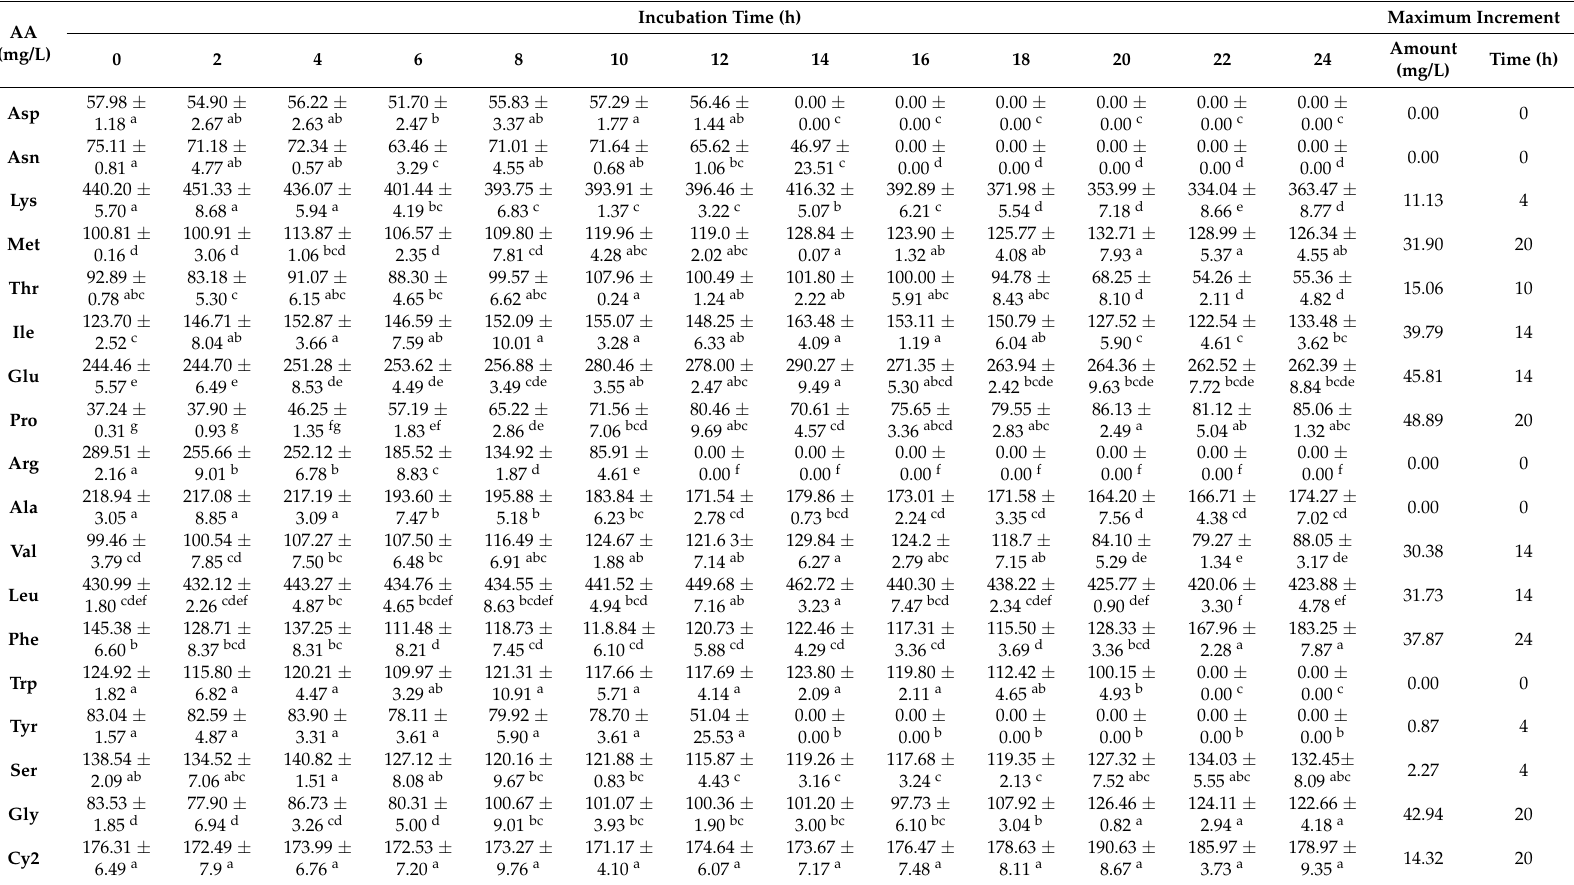
Table 4. The amino acid production profile of P. pentosaceus